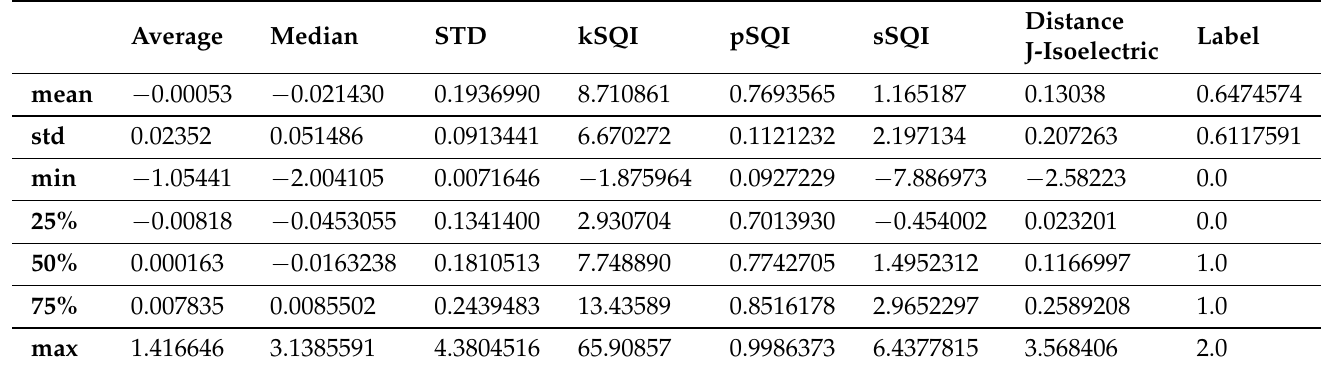
Table 2. Description of the final dataset generated by selecting statistical characteristics and the distance to